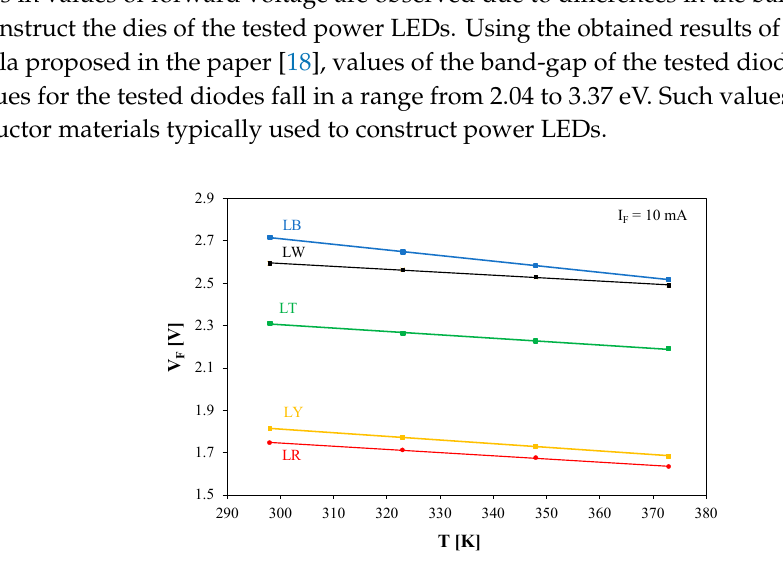
Figure 7. Calibration curves of selected power LEDs.